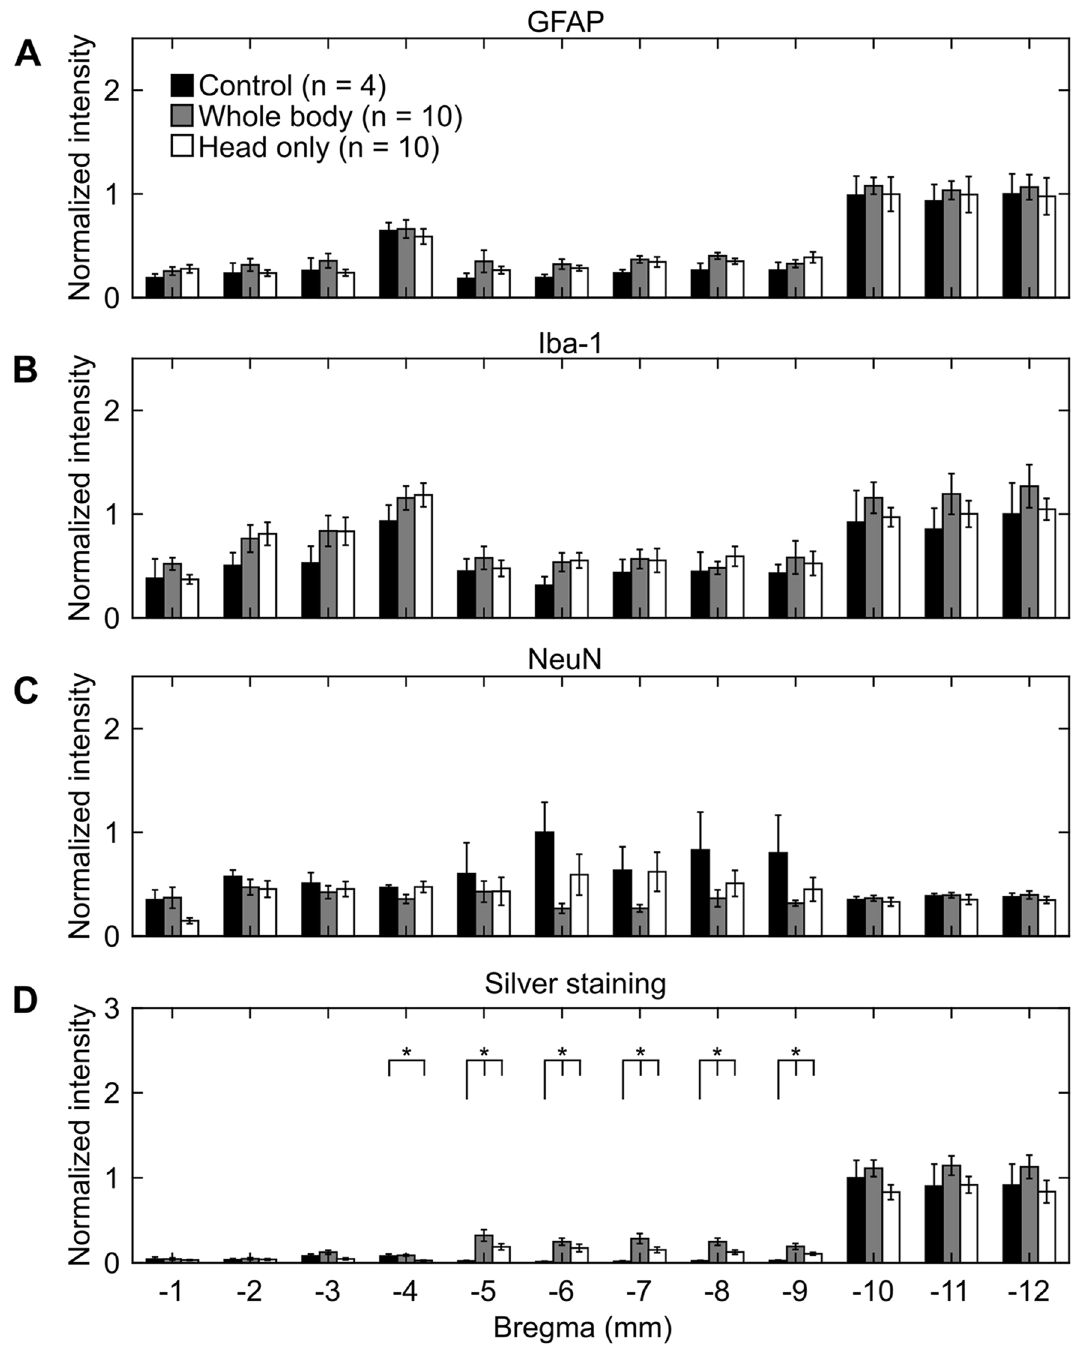
Figure 6. Changes in coronal brain slices due to whole-body or head-only blast exposure in the direct- mechanism study, as indicated by ( A ) GFAP-positive, ( B ) Iba-1-positive, ( C ) NeuN-positive, and ( D ) silver staining. Asterisks denote statistically significant differences (p < 0.05) between blast-exposed (n = 10) and control (n = 4) groups. The bar heights and vertical line lengths represent the mean and one standard error of the mean (SEM), respectively. At each brain-slice region for each group, we determined the mean and SEM using the corresponding brain-slice data. For each staining assessment, we then normalized the data for controls by the highest control value. Lastly, we normalized the data from blast-exposed groups (i.e., whole-body and head-only) by the data from their respective controls at each region. We normalized the data for presentation purposes only. We conducted all statistical analyses using the raw data with their respective